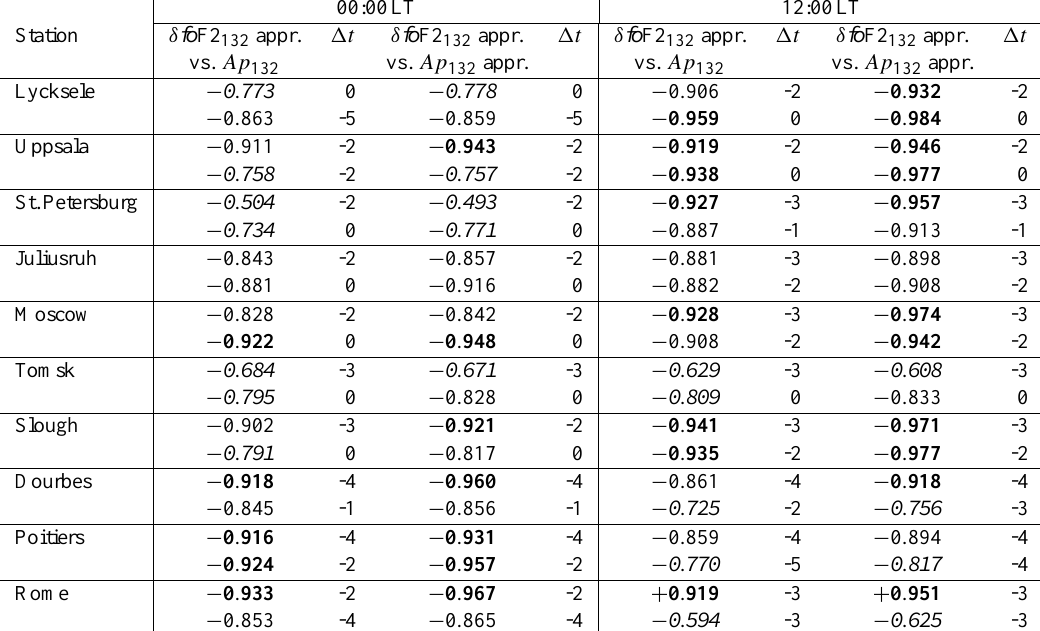
Table 1. Correlation coefficients, r , between δ fo F2 132 and Ap 132 found over one and the same period 1957–97 (1962–92 after 11-year smoothing). The “appr.” refers to the polynomial approximated δ fo F2 132 and Ap 132 variations. The first line refers to Q -medians, the second to the usual monthly fo F2 medians used in the calculations. Bold face figures show significant r with a confidence level 99%, normal face figures correspond to 95% confidence level, italic figures are not significant r . The optimal time shift 1t (in years) between δ fo F2 132 and Ap 132 variations is given as